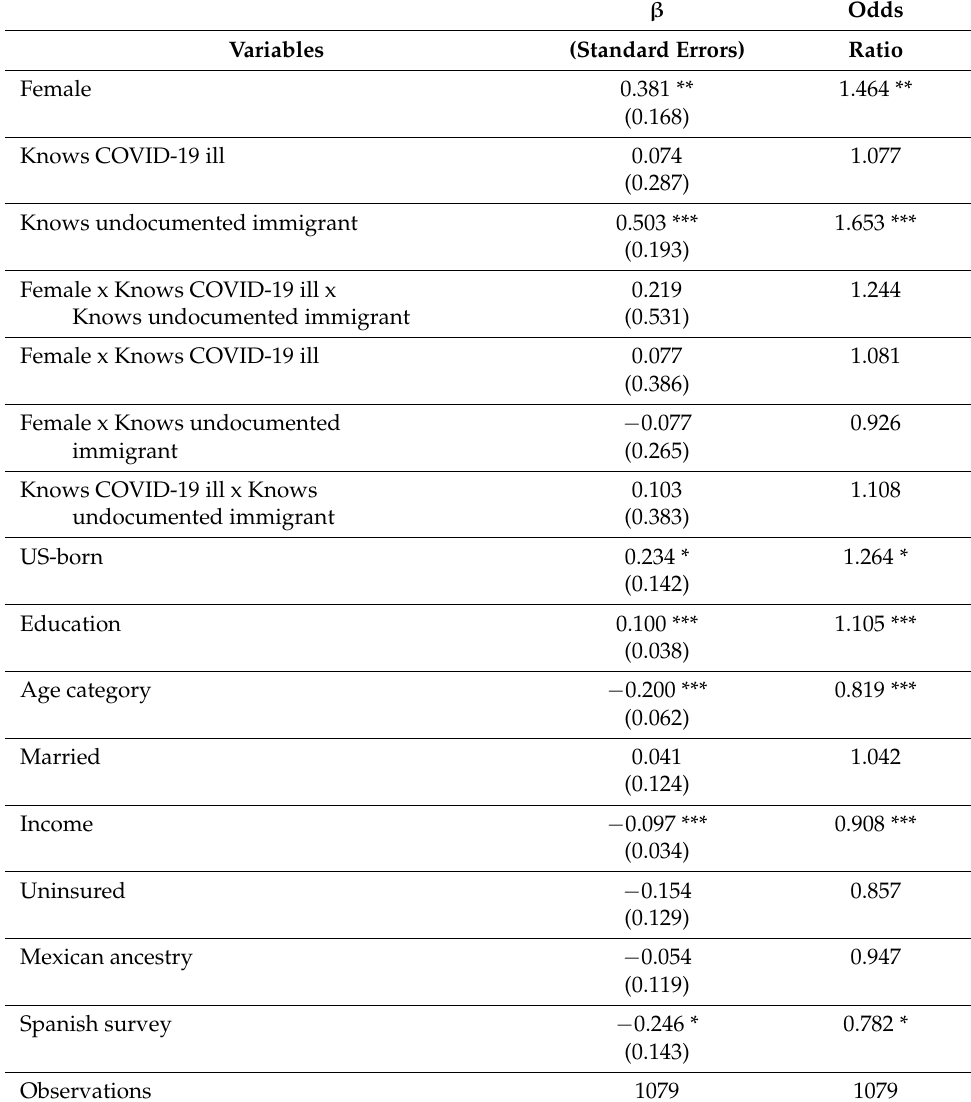
Table 3. Ordered logistic regression assessing the intersectional implications of COVID-19 on mental health (three-way Interaction among gender, knowing someone with COVID-19, and knowing an undocumented